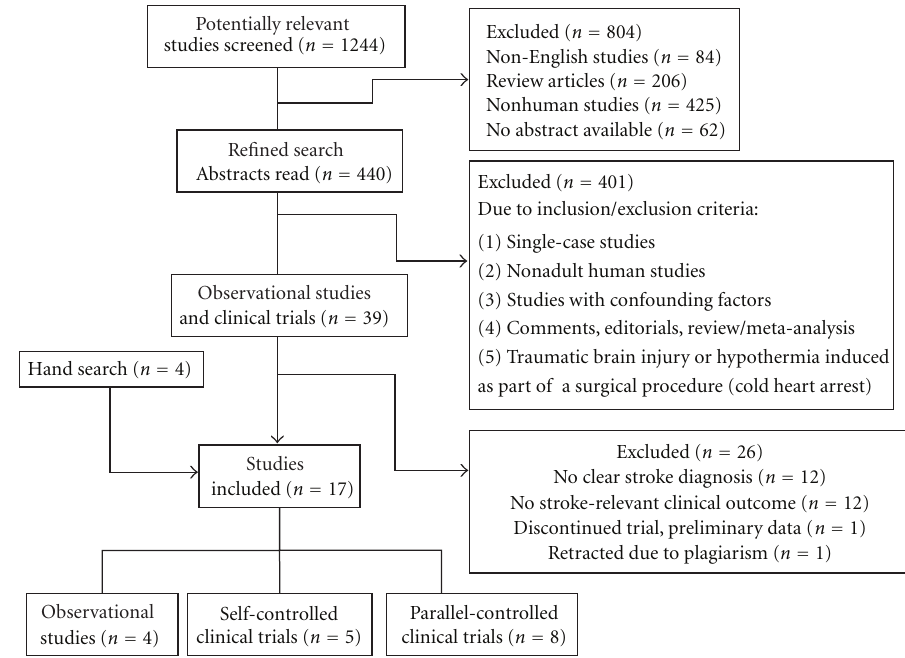
Figure 1: Flow chart of the systematic